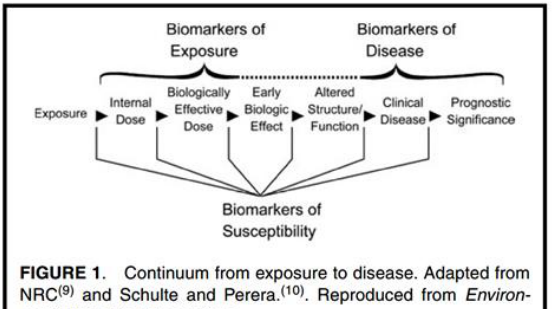
Figure 2. Continuum from exposure to disease. Source DeBord et al., 2015 [56].